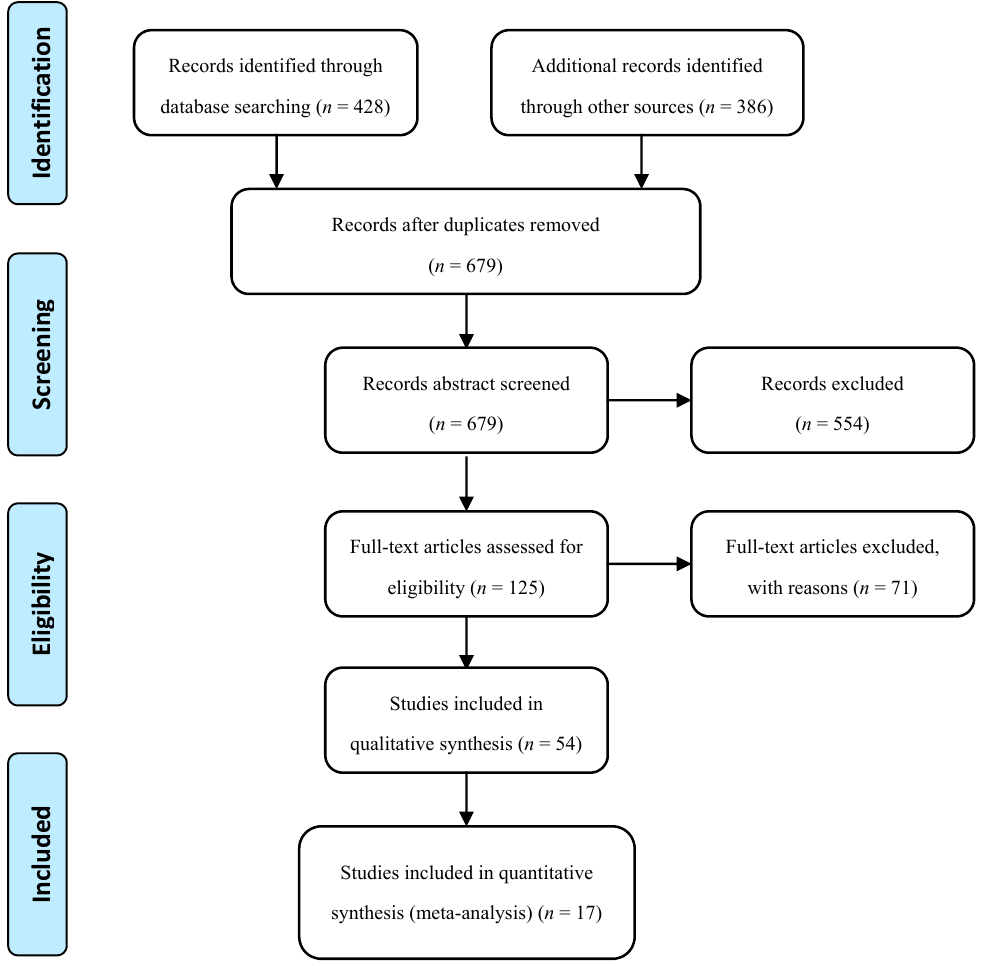
Figure 1. Study selection through the different phases using PRISMA framework [21].